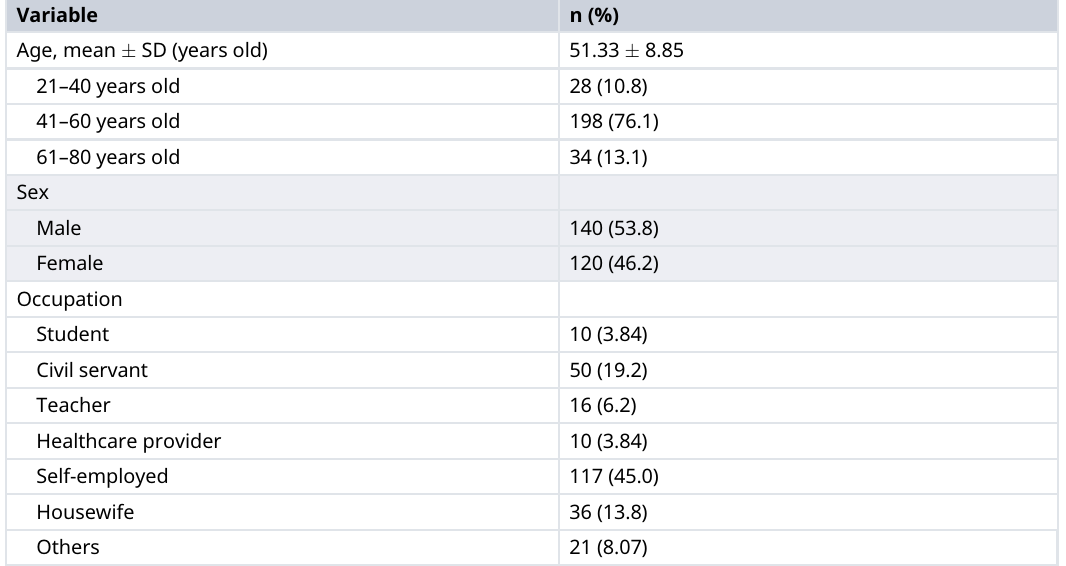
Table 1. Demographic characteristics of COVID-19 patients with diabetes mellitus.